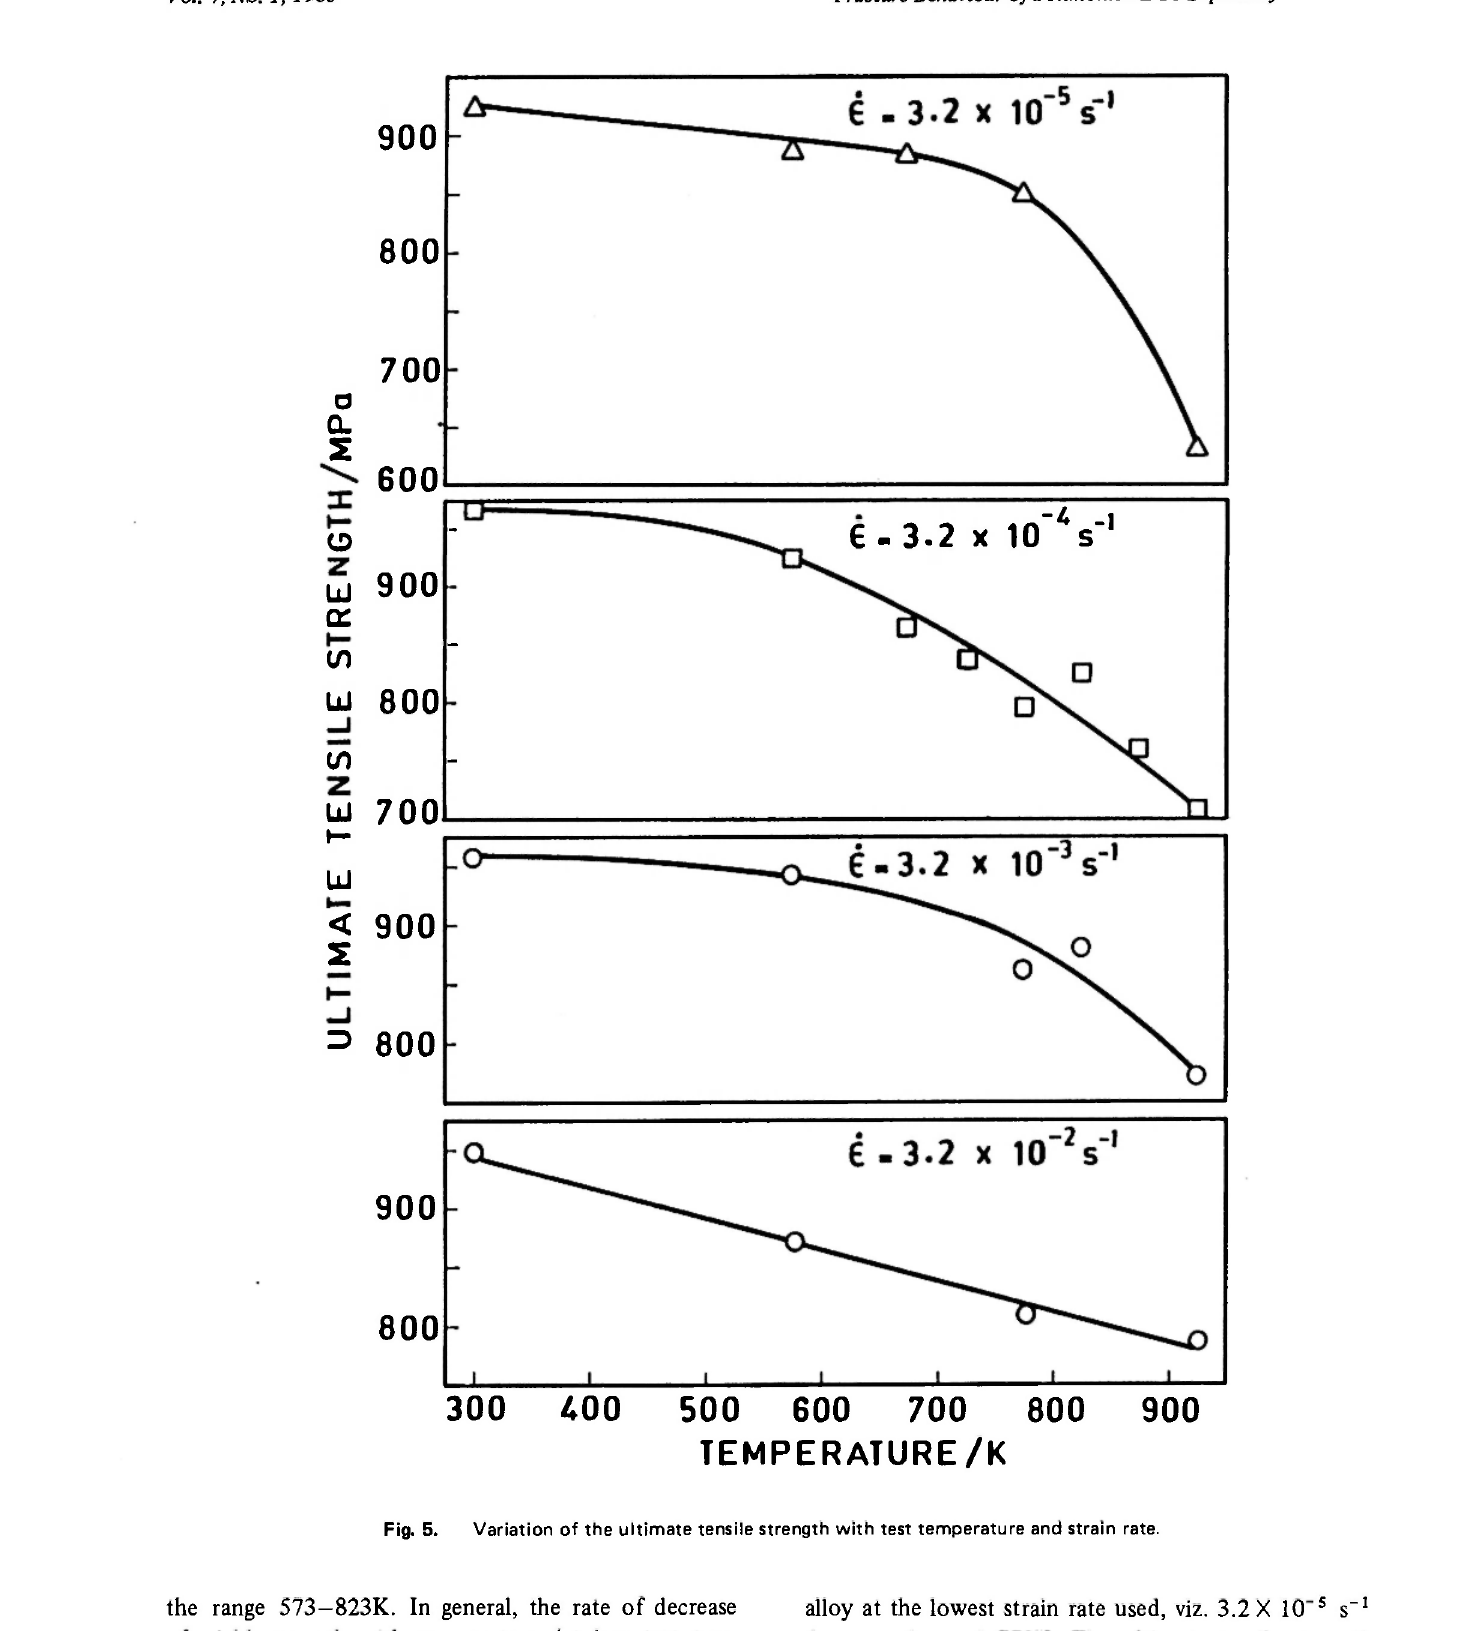
decreases beyond 773K. The ultimate tensile strength of the alloy decreases with an increase in the test tem- perature at all the strain rates employed (Fig. 5).